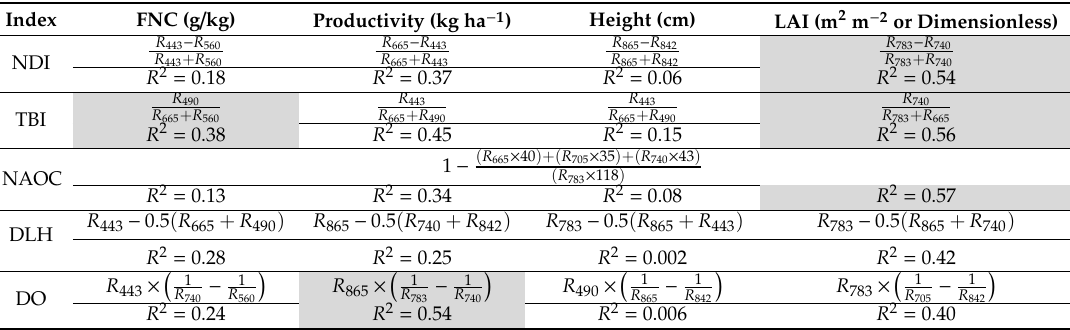
Table 5. Results of the best bands obtained from the Sentinel-2 satellite for the di ff erent vegetation indices, as a function of the biophysical parameters studied (productivity, FNC, height and leaf area index (LAI)) for Mombasa and Marandu dataset. The best results are shown shaded.